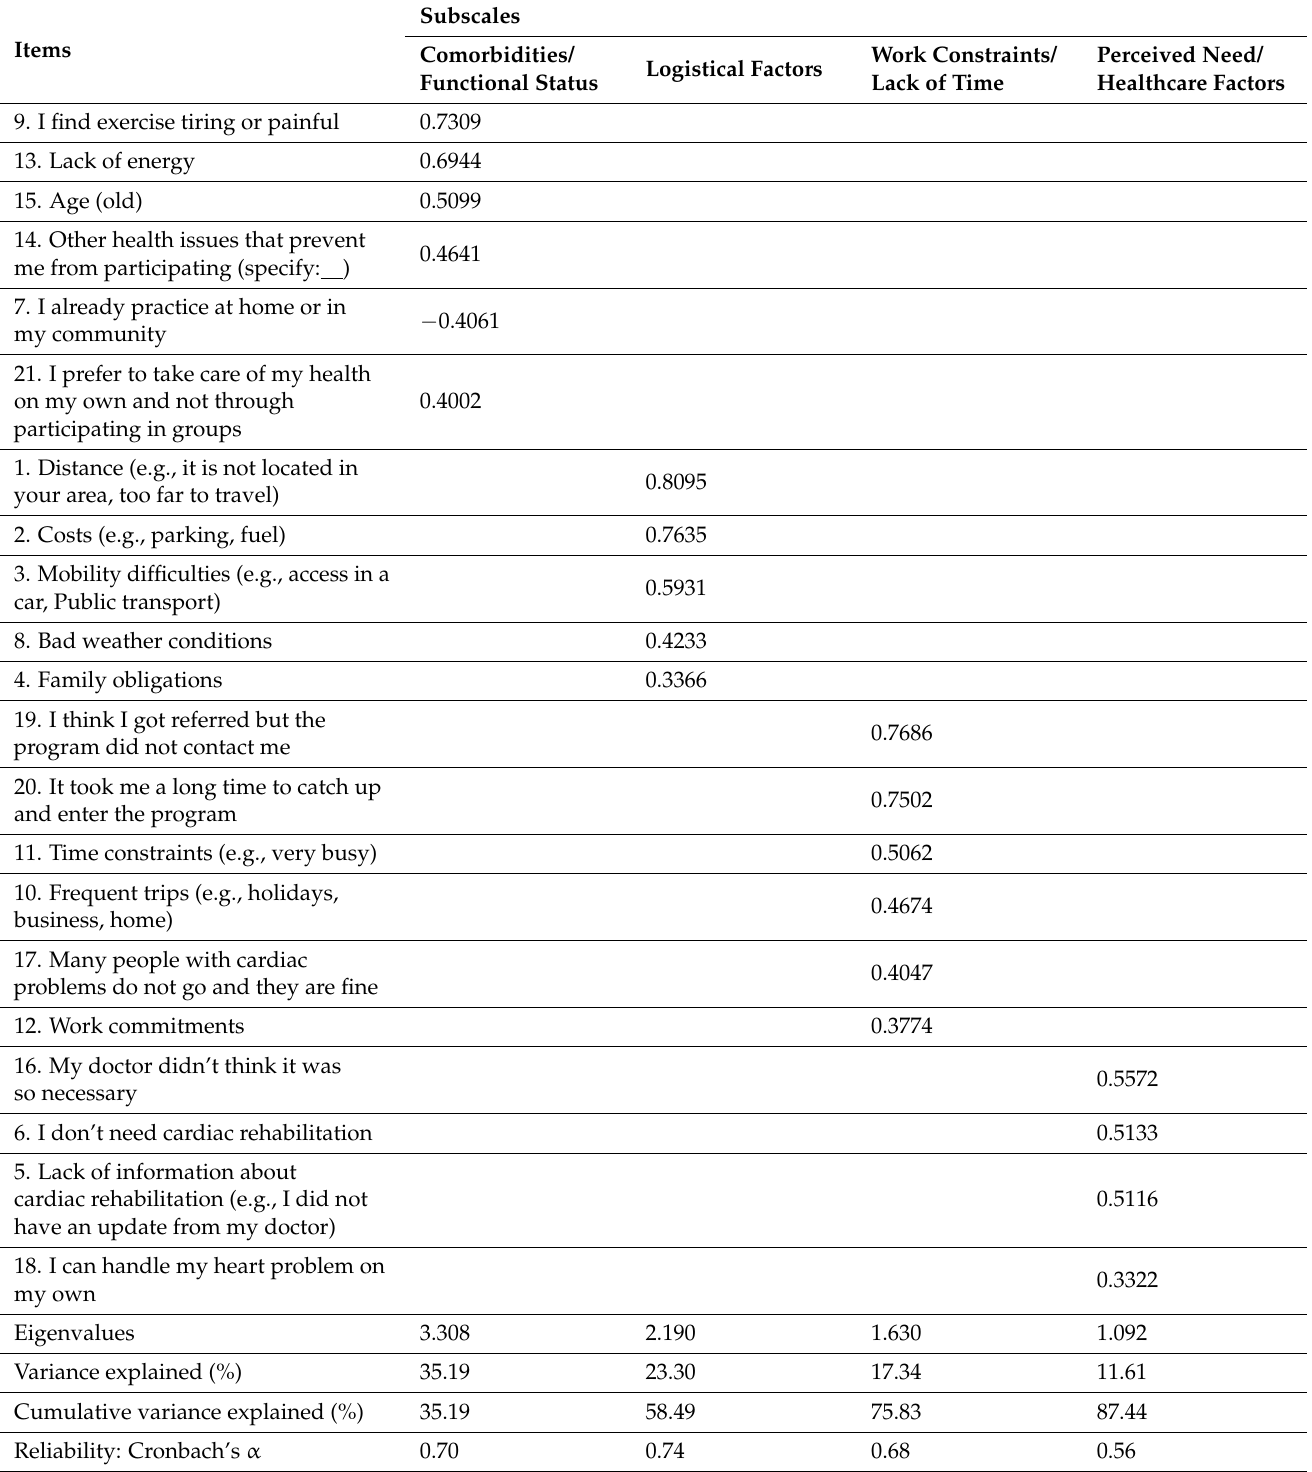
Table 3. Factor Loadings * from Exploratory Factor Analysis (N =